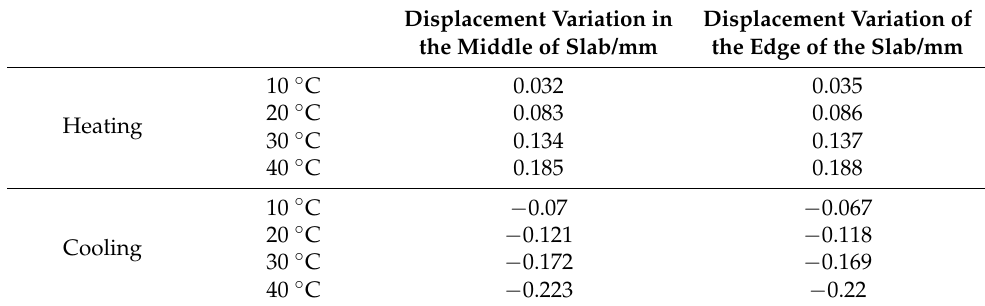
Table 4. Displacement changes in the middle of the slab track and the edge of the slab during the overall heating and